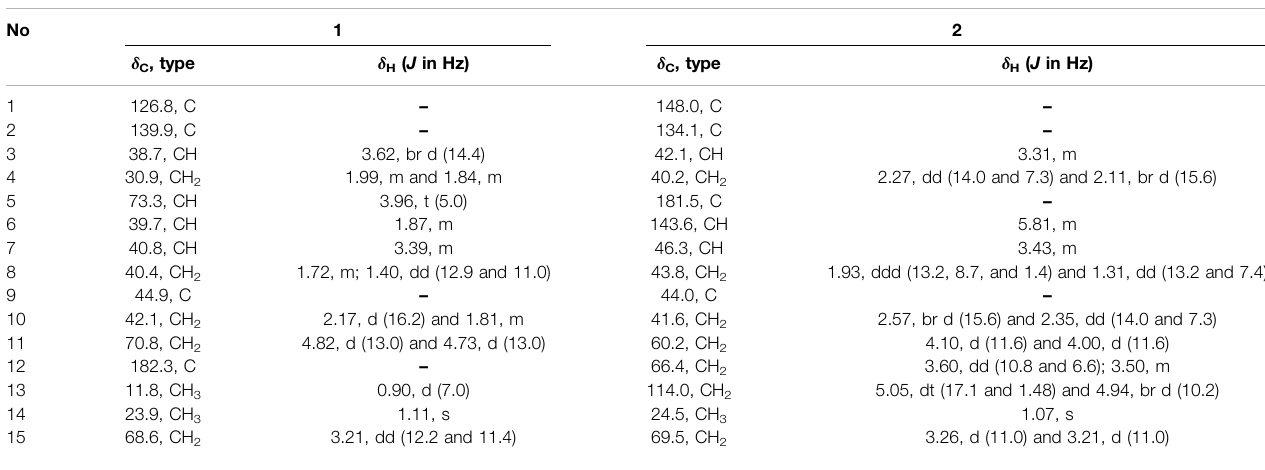
TABLE 1 | 1 H (400 MHz) and 13 C (100 MHz) NMR spectroscopic data of 1 and 2 in CD 3